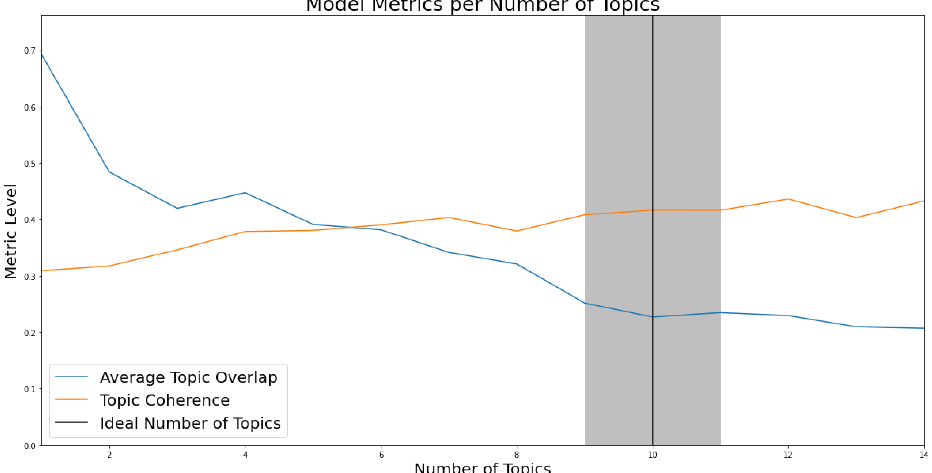
Figure 1. Latent Dirichlet allocation (LDA) [51] across different numbers of topics, Jaccard similarity, and coherence for each.